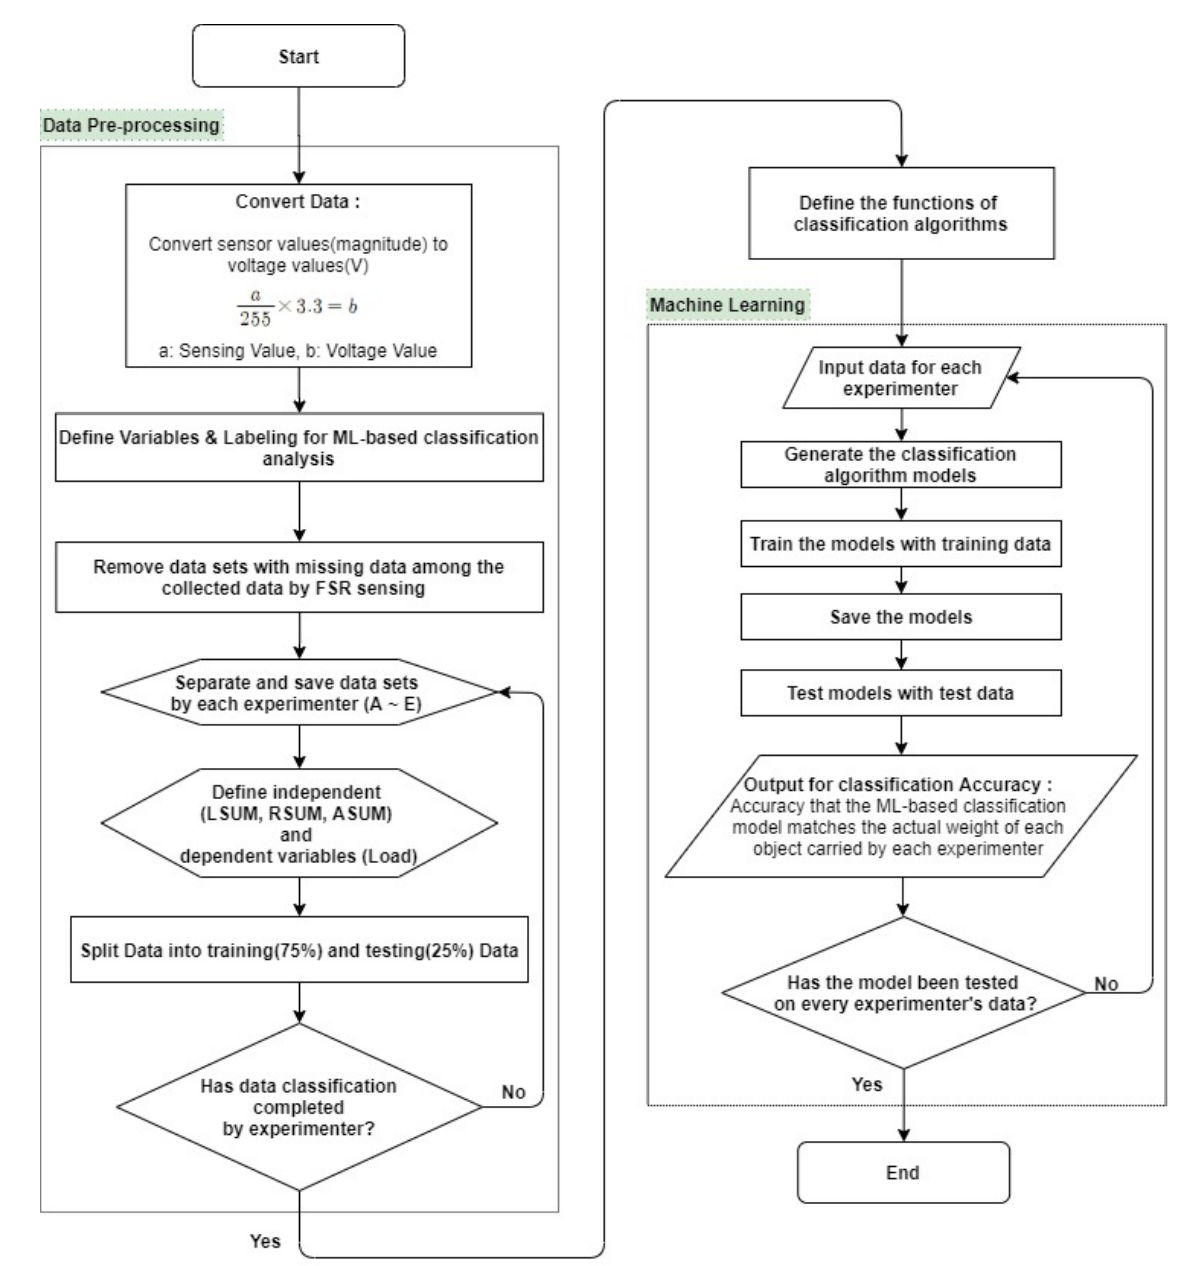
Figure 2. An analysis model using Machine Learning (ML). LSUM: Conversion value of SumRawL to voltage; RSUM: conversion value of SumRawR to voltage; ASUM: sum of LSUM and RSUM.